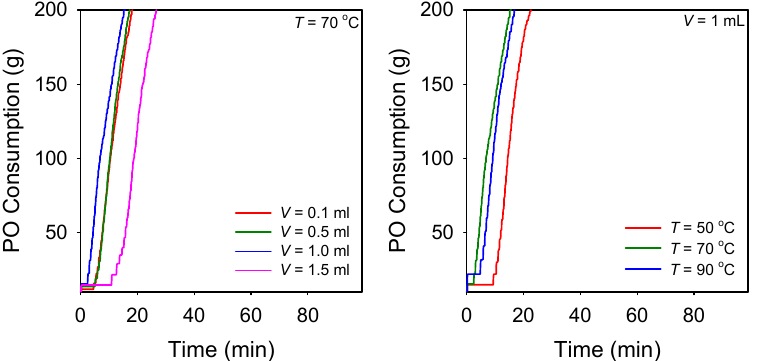
Figure 5. PO polymerization rate curves obtained by DMC-DMAc prepared at 70 ◦ C using various amount of CA (left) and prepared at different temperatures using 1 mL of CA. Polymerization condition: T p = 115 ◦ C, PPG-400 ( F = 2) starter = 20 g, and DMC-DMAc = 100